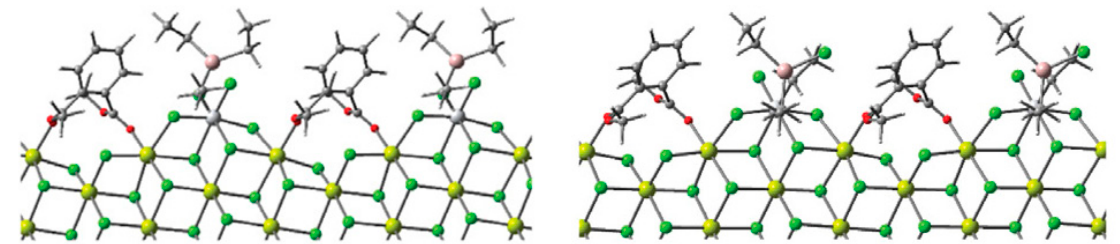
Figure 8. Optimized geometries of Ti–( μ -Cl) 2 –Al and Ti–( μ -Cl)( μ -Et)–Al species formed during the alkylation of Ti chloride at the (110) surface of MgCl 2 . Reprinted with permission from [114]. Copyright (2017) Elsevier B.V.